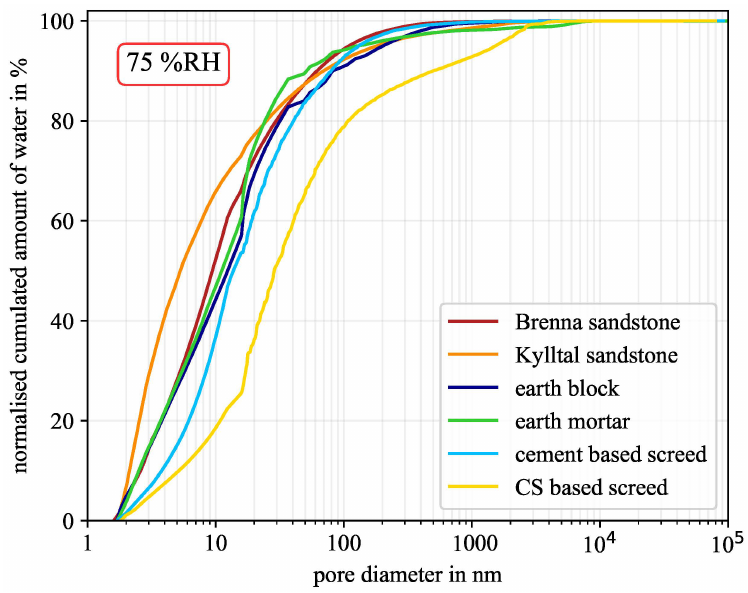
Figure 7. Normalised cumulated amount of water at 75% RH for the six material samples. (CS—calcium sulphate).